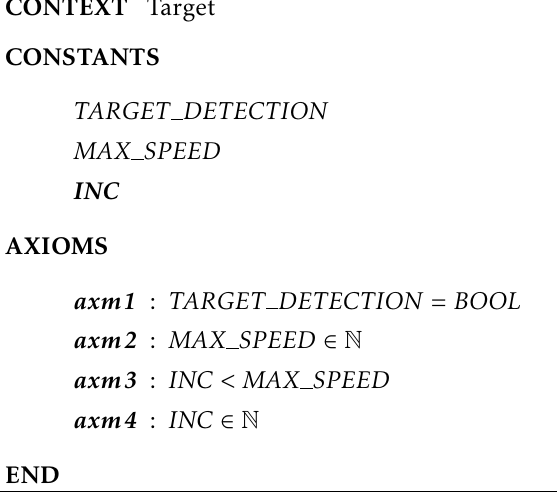
Figure 4. Abstract context of initial ACC system Strengthen guards: With the initial description, the generated INV POs of the translated Event-B generated as follows: